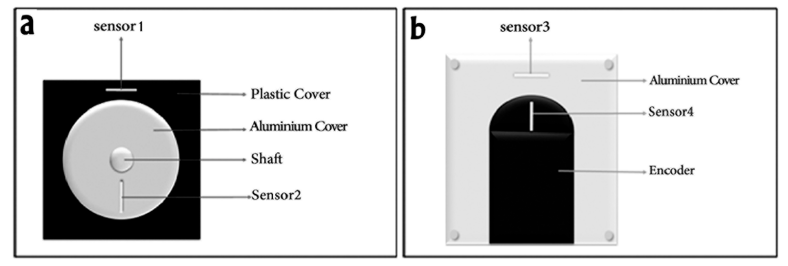
Figure 3. Sensor locations: ( a ) Motor front view; ( b ) Motor rear view.